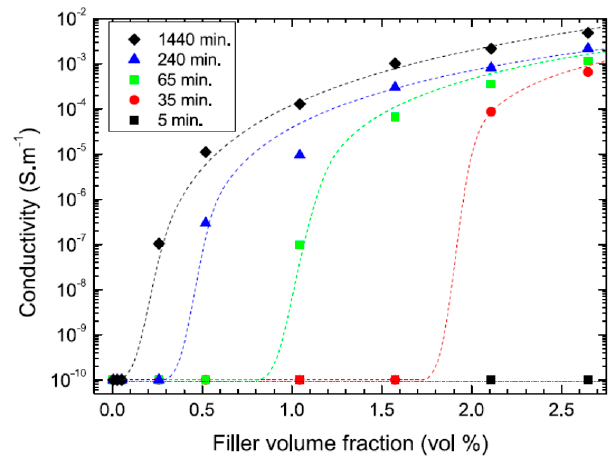
Figure 13. Variation of conductivity with filler amount at different annealing steps for MWCNT/VLDPE [66].